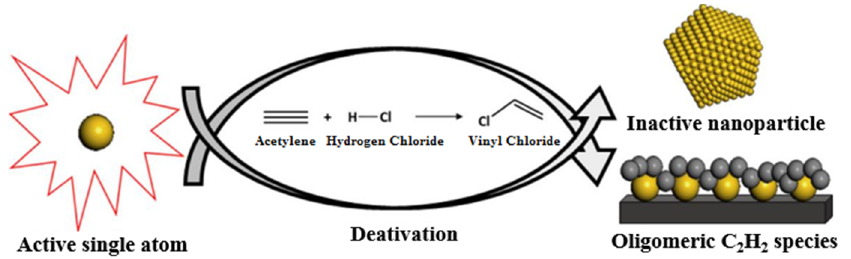
Figure 11. Deactivation of a single-site Au 0 catalyst [83].